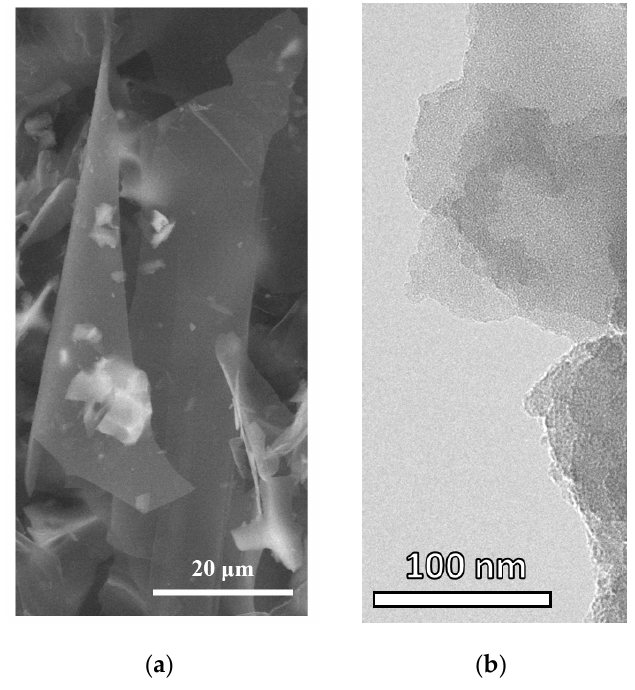
Figure 3. SEM ( a ) and TEM ( b ) images of FLG-SHS.